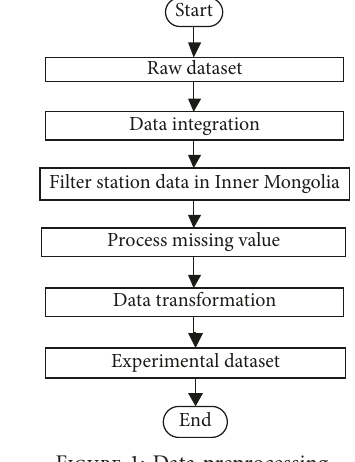
Figure 1: Data preprocessing. Table 1: Balanced daily